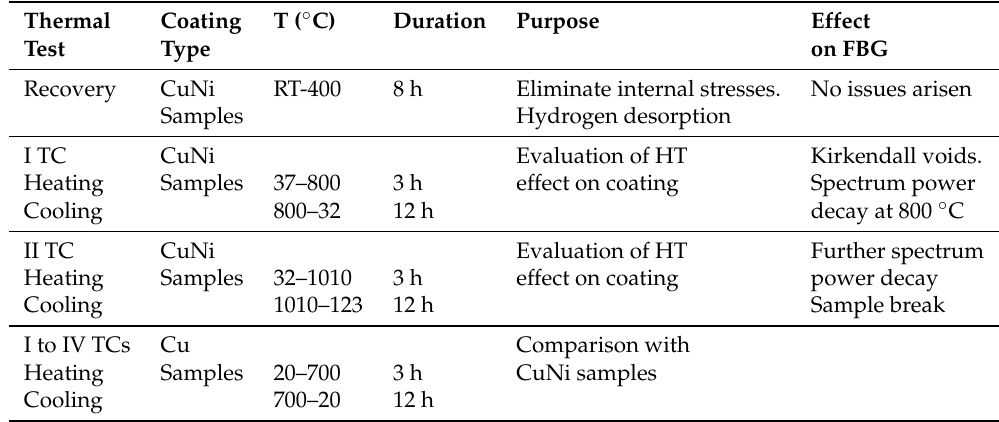
Table 1. Thermal cycles’ (TC)